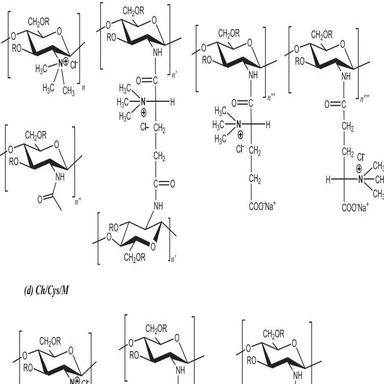
SEM images of chitosan and its derivatives.